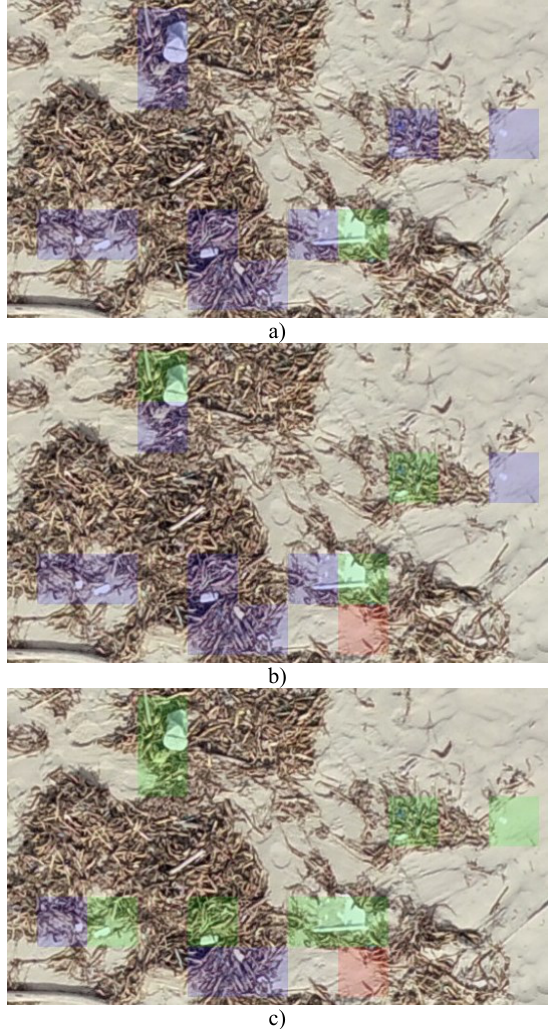
Figure 6. Details of the results for the beach. Blue tiles are false negatives, red tiles false positives and green tiles true positives. a) baseline, b) w100 and c)